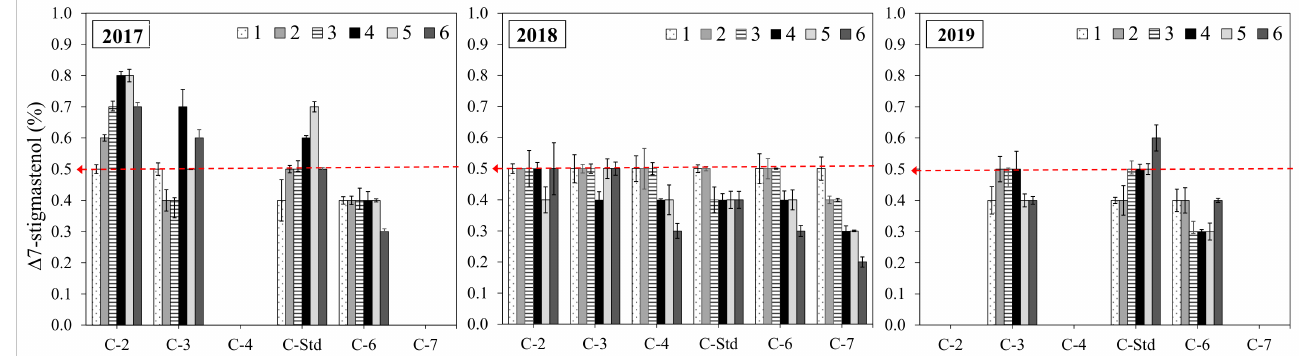
Figure 3. Evolution of ∆ 7-stigmastenol (%) according to harvest date and clone (C-2, C-3, C-4, C-6, C-7, and C-Std) in the three crop years studied (2017, 2018, and 2019). Harvest dates: 1 (1–4 October), 2 (16–18 October), 3 (28 October–7 November), 4 (11–22 November), 5 (25–29 November), and 6 (11–13 December). Non-compliance norm: ∆ 7-stigmastenol > 0.05 (%). Red arrow: limit established by the current EU/IOC/CODEX regulatory for OOV for ∆ 7-stigmastenol ≤